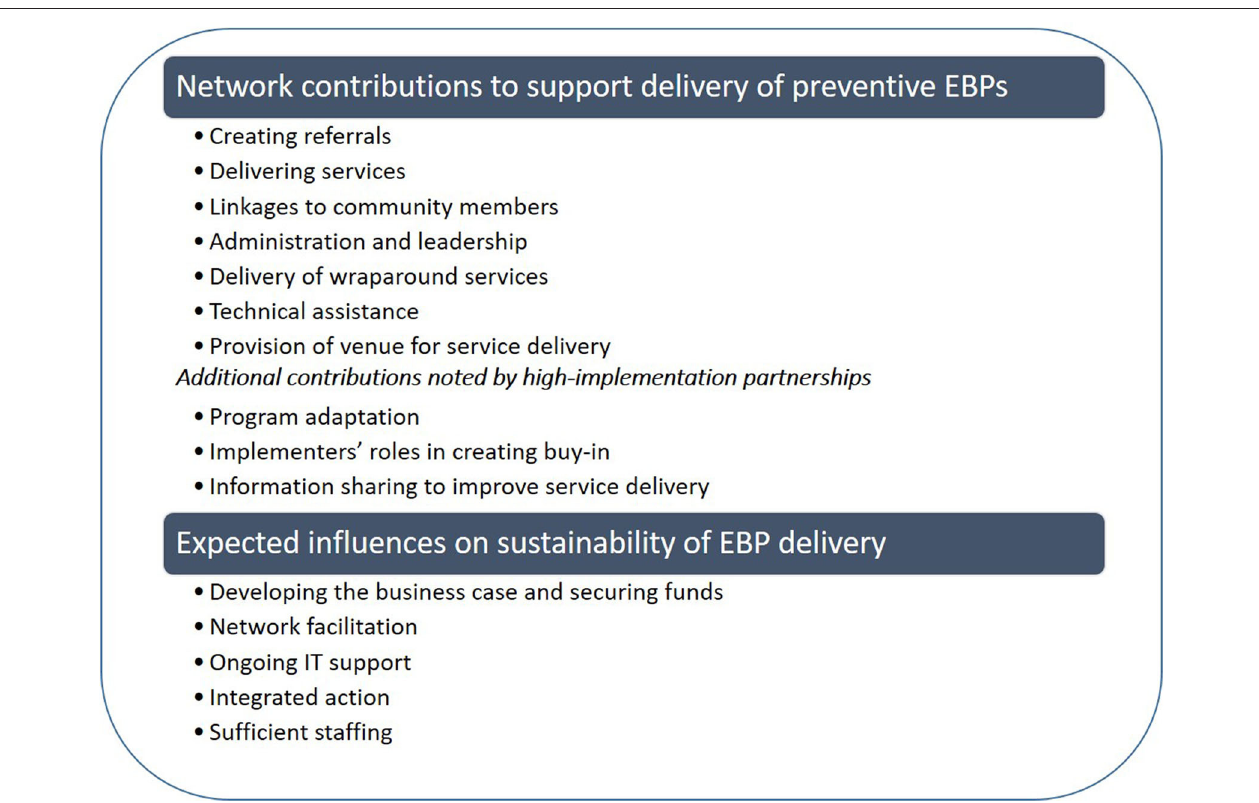
FIGURE 1 | Key themes identified in the analysis, organized by topic and presented in order of decreasing